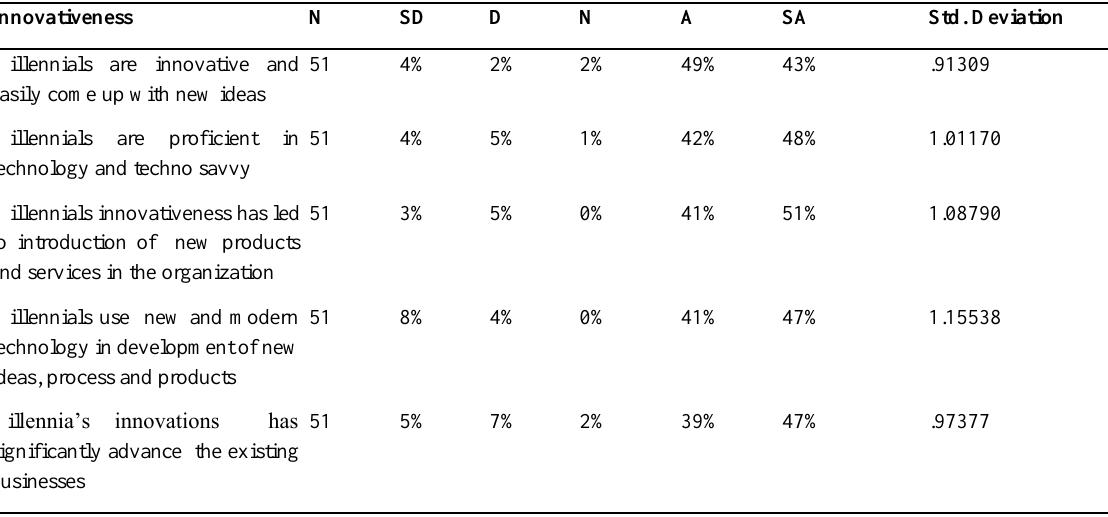
Table 1: Influence of millennials innovativeness on organization